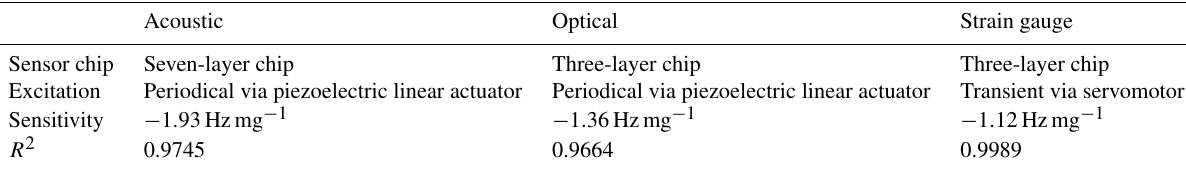
Table 2. Comparison of the investigated measurement